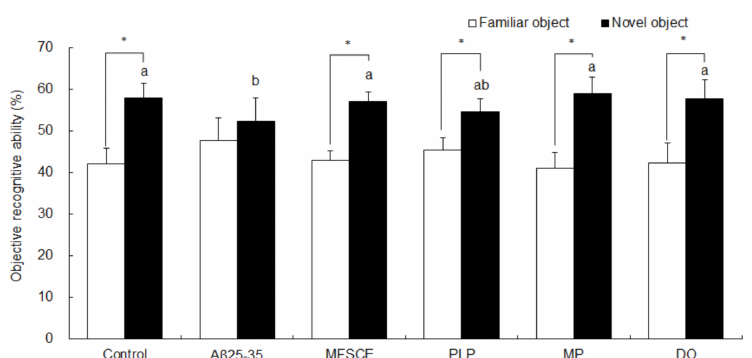
Figure 3. Effect of MFSCE on object perception ability by novel object recognition test in A β 25–35 - injected mice. a,b Means with different letters are significantly different ( p < 0.05) from each group in the test session. Data are expressed as mean ± SD ( n = 8). * The object perception abilities for familiar and novel objects differed significantly when analyzed by the Student’s t -test ( p < 0.05).